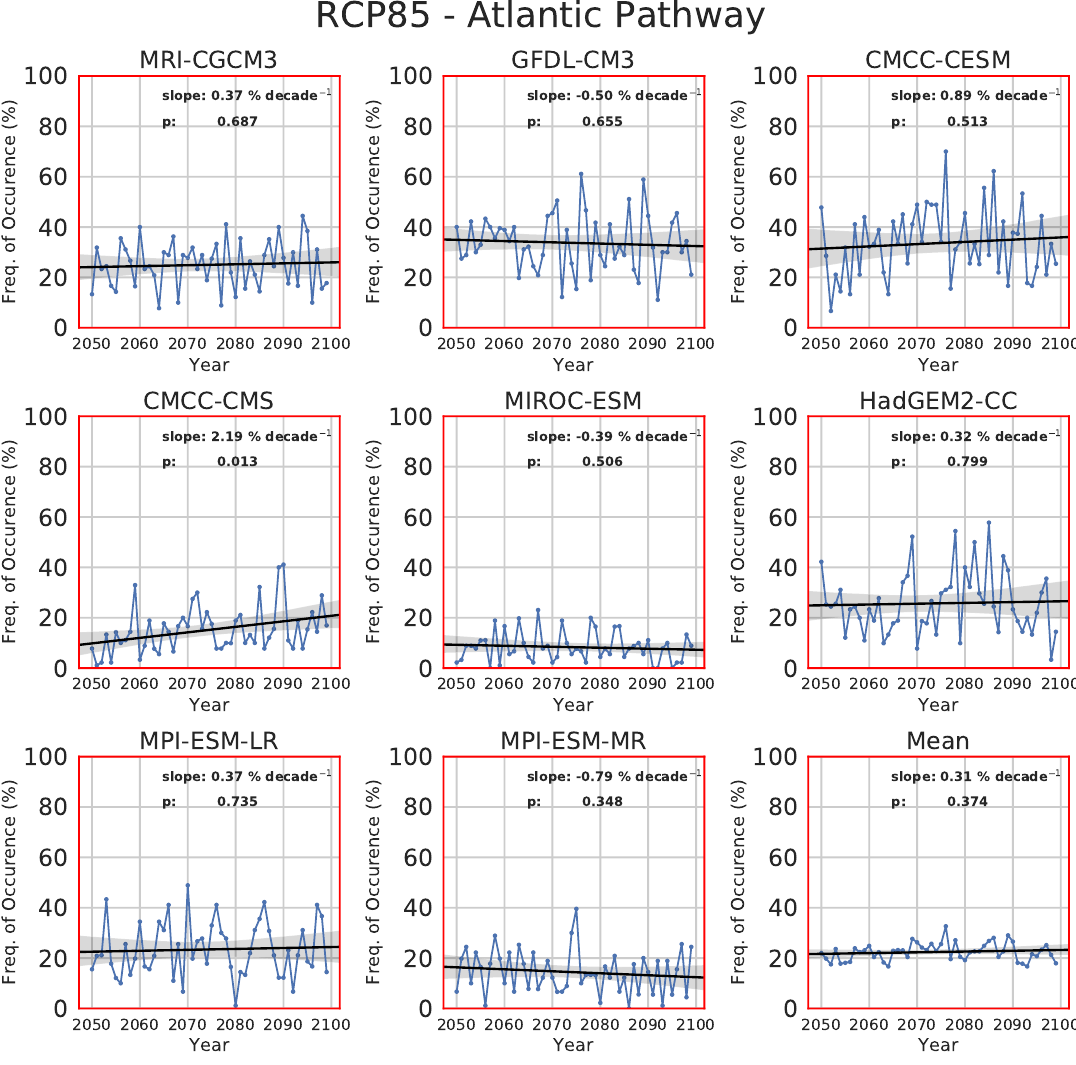
Figure 11. Atlantic pathway’s relative occurrence frequencies for each model and a multi-model mean derived for each winter (blue line) of the RCP8.5 time frame (2050 to 2099). The linear trend is shown as black line, and greyshading shows the 95% confidence intervals for the trends derived by bootstrap resampling. p values are shown according to a two-sided t